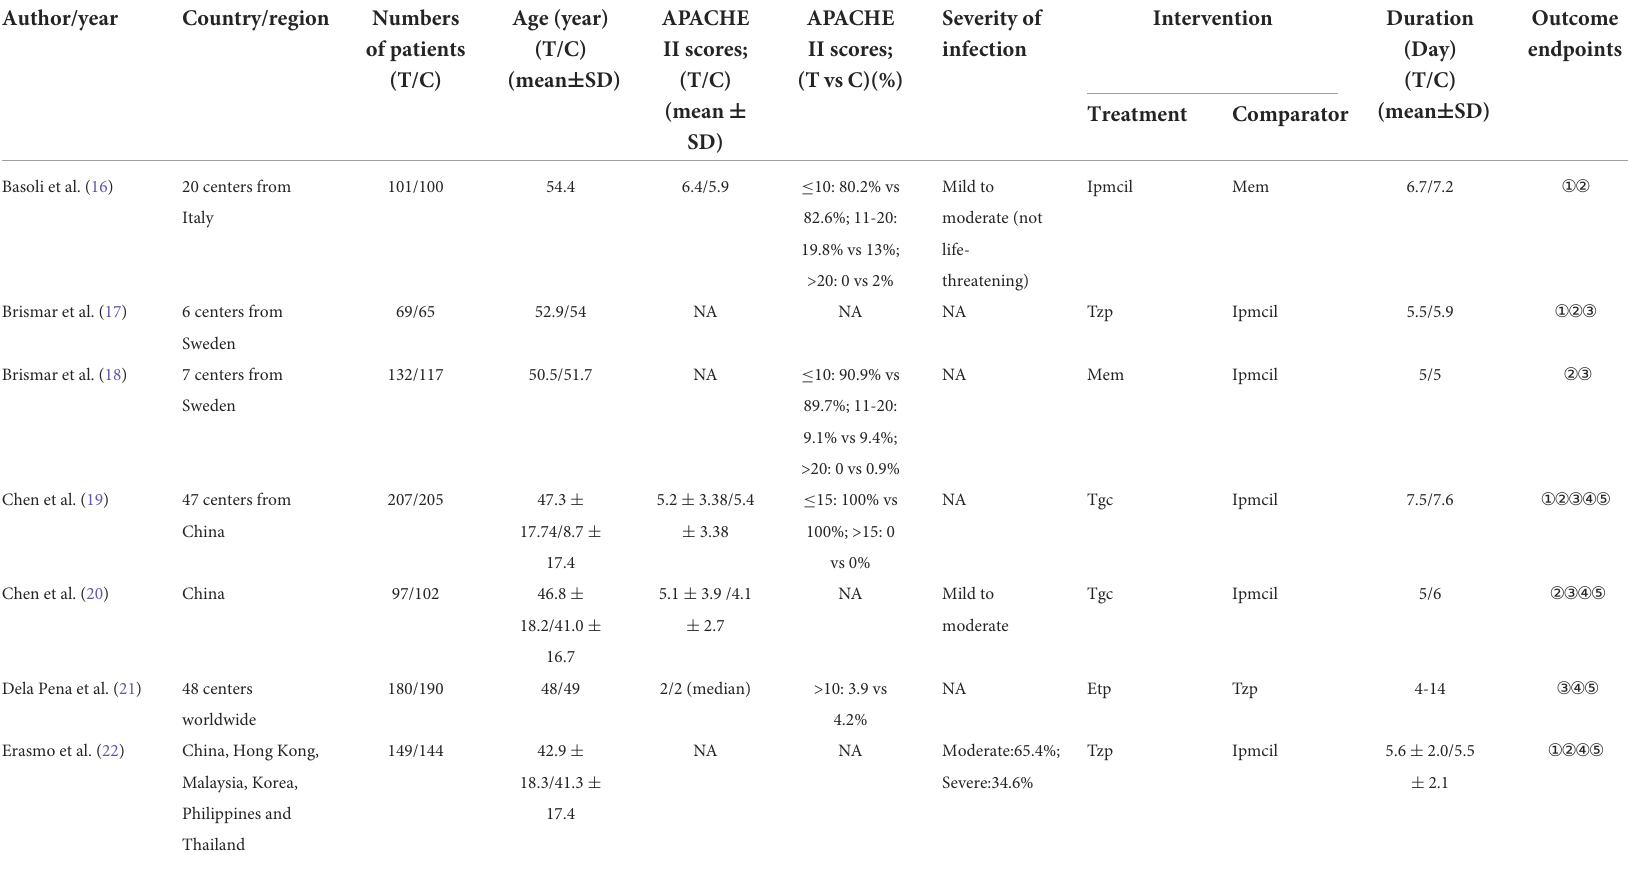
TABLE 1 Characteristics of included